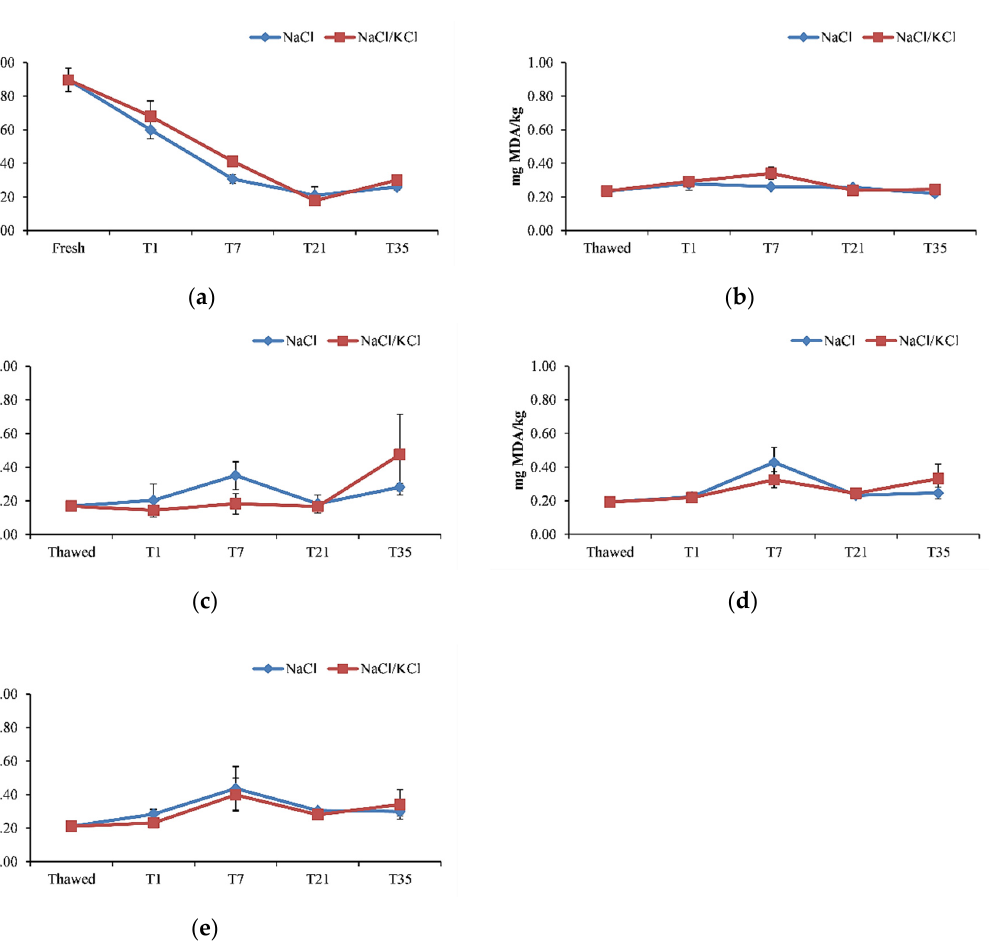
Figure 3. Malondialdehyde (MDA) levels (mg/kg) in the smoked fillets of D. labrax during the 35 days of preservation, in the five smoking processes. ( a ) smoking I; ( b ) smoking II; ( c ) smoking III; ( d ) smoking IV; ( e ) smoking V.